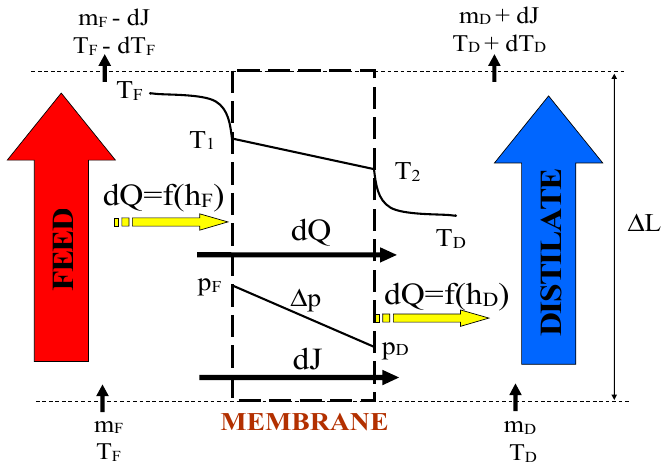
Figure 1. Scheme of heat and mass transfer in membrane distillation (MD) process. m i —mass flow rate [kg/s].